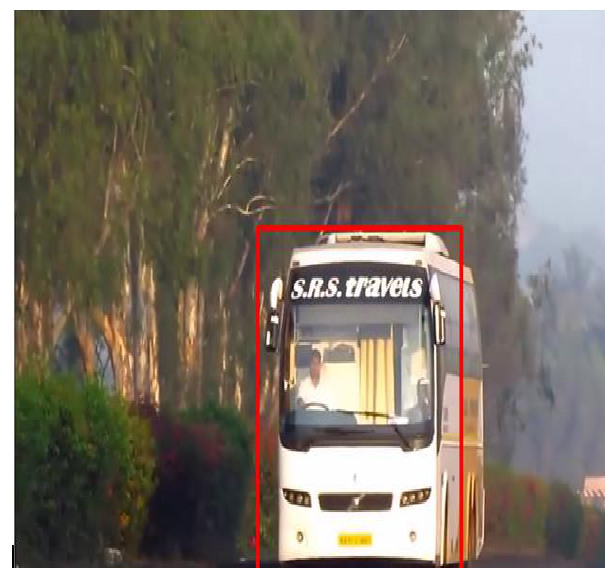
Figure 8. When the user selects bus detection (ref. Figure